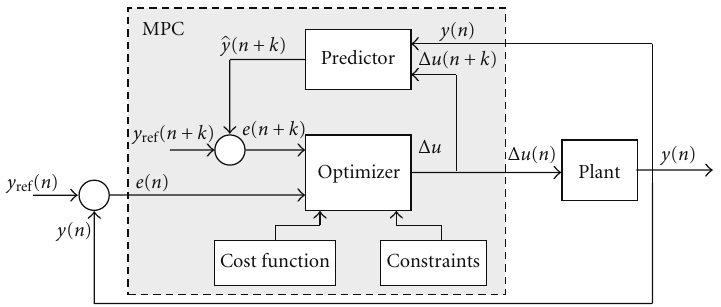
Figure 1: Basic structure of model predictive